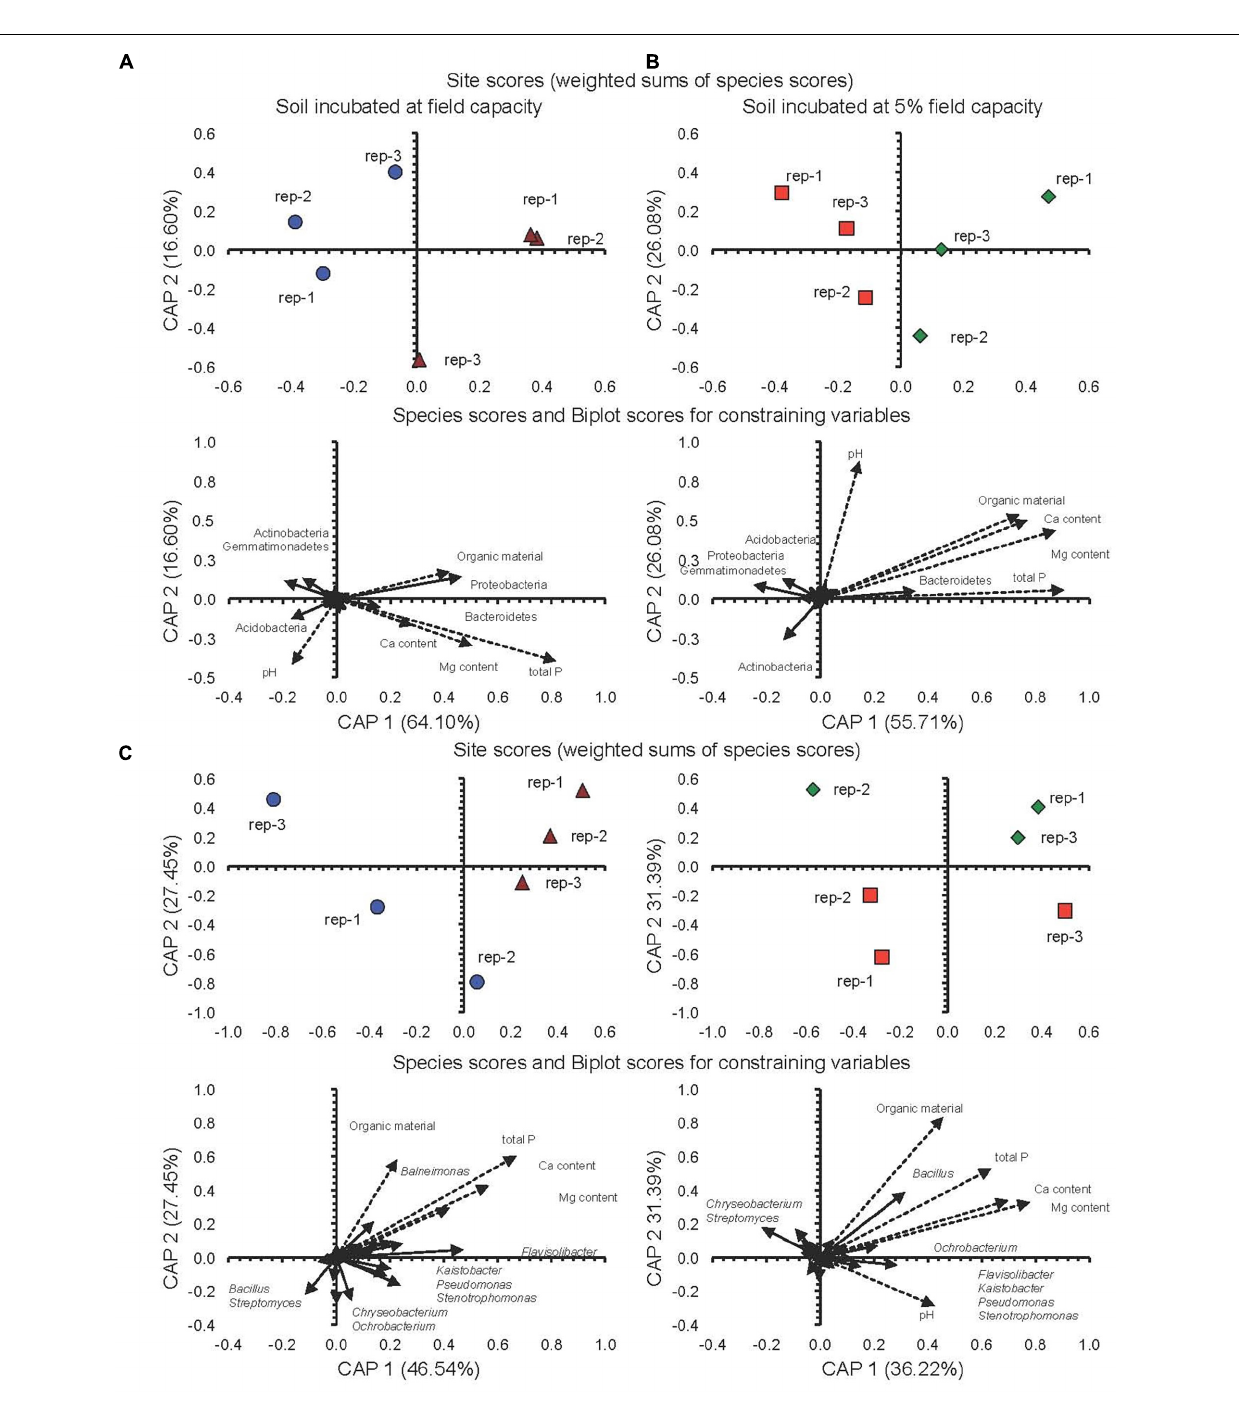
amount of CO 2 emitted in the aerobic incubation in this study after 45 days. Application of the milpa system had increased the soil organic C content 1.8 times and the CO 2 emitted from